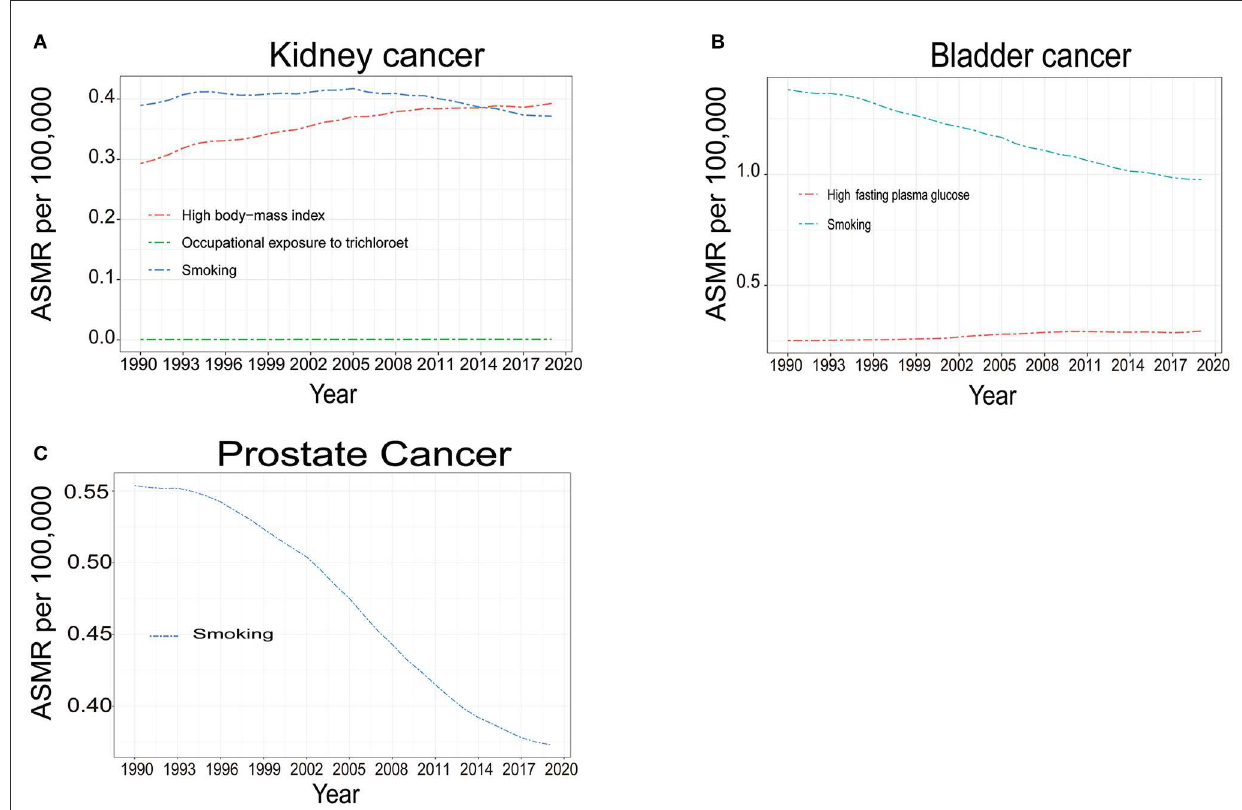
FIGURE6 The temporal trends of global age standardized mortality rate (ASMR) attributable to risk factors of kidney cancer (A) bladder cancer (B) and prostate cancer (C) for both sexes from 1990 to